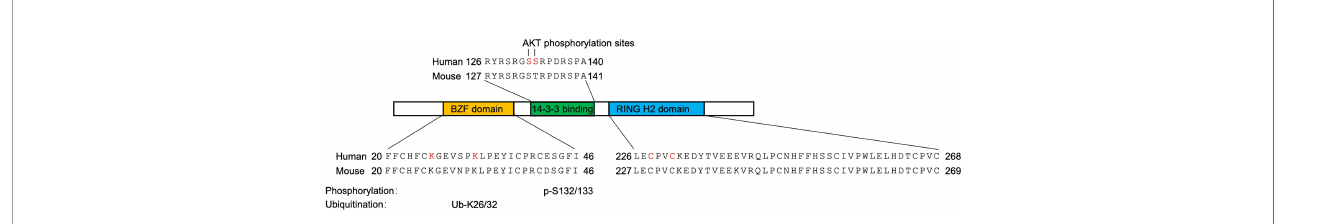
FIGURE 1 | Conserved domains of RNF115. The BZF domain (yellow) binds ubiquitin and is the site of RNF115 auto-ubiquitination (ubiquitinated lysine residues are shown in red). The 14-3-3 binding domain (green) is site of RNF115-14-3-3 interaction (AKT phosphorylation residues are shown in red). The RING H2 domain (blue) is the site of RNF115 autoubiquitination. The E3 ligase activity residues were shown in